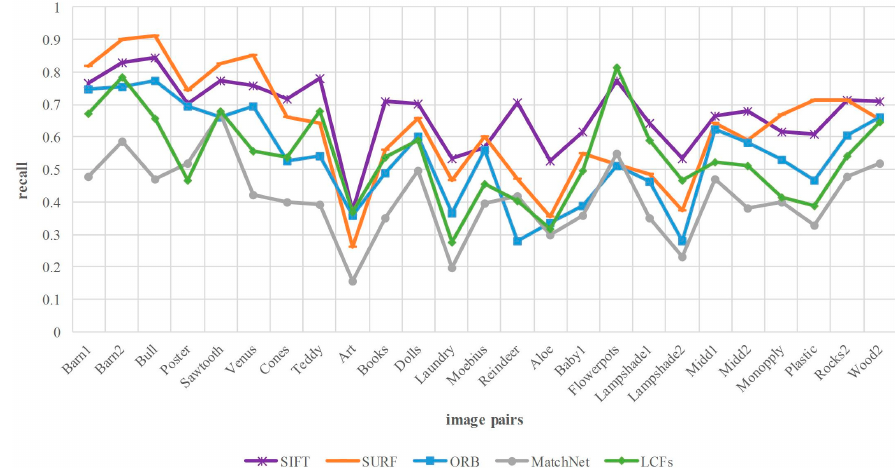
Figure 10. Matching recall comparison between our method and four comparing approaches on Middlebury dataset. The horizontal axis denotes the image pairs, and the vertical axis is the matching recall.